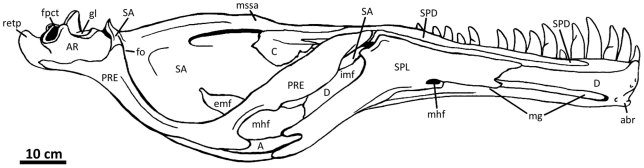
Left mandible of Acrocanthosaurus atokensis (NCSM
14345) in medial view.
A, angular; AR, articular; abr,
articular brace of the dentary; C, coronoid;
D, dentary; emf, external mandibular fenestra;
fo, foramen; fpct, foramen posterior
chorda tympani; gl, glenoid region; imf,
internal mandibular fenestra; mg, Meckelian groove;
mhf, mylohyoid foramen; mssa, medial shelf
of the surangular; PRE, prearticular; retp,
retroarticular process of articular; SA, surangular;
SPD, supradentary; SPL, splenial.